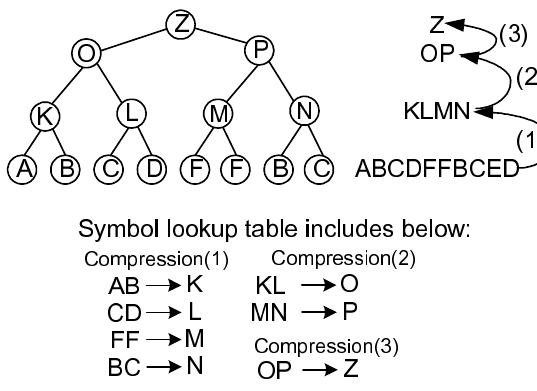
Figure 2. An example of a succinct data structure using a binary